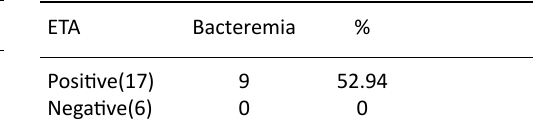
Table 4. Showed the frequency of human P. aeruginosa bacteremia in relation to ETA